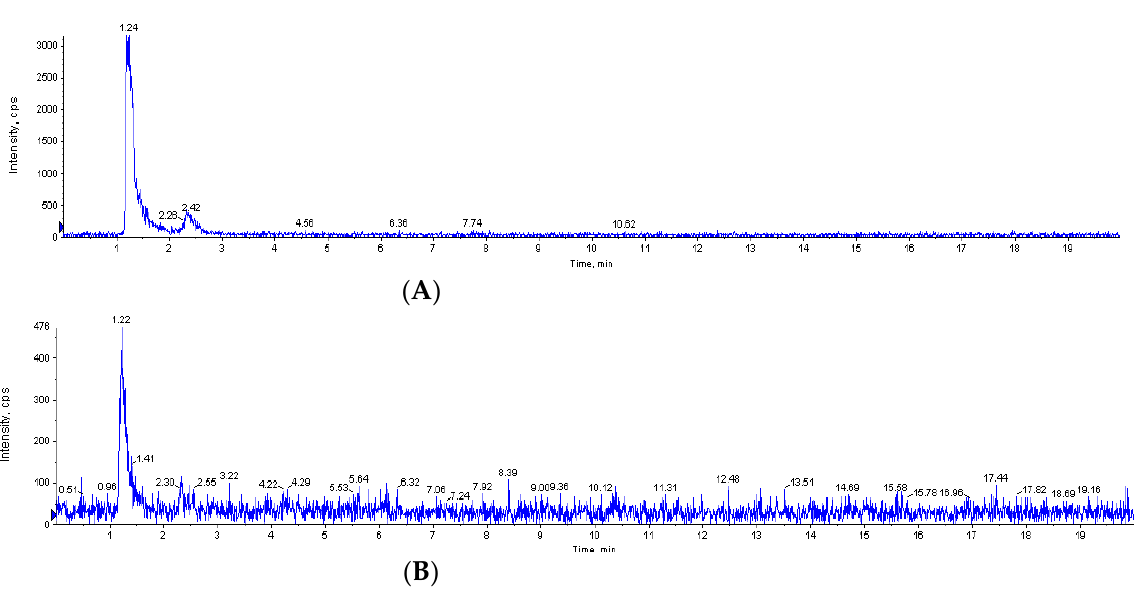
Figure 4. LC-MRM adducts: ( A ) DHA + POBN adduct; ( B ) EPA + POBN adduct. Catechol, hydroxytyrosol (HO-Tyr), α -tocopherol, syringic acid, caffeic acid, and oleuropein (Olp) are being used to evaluate their effects on oxidative stability.